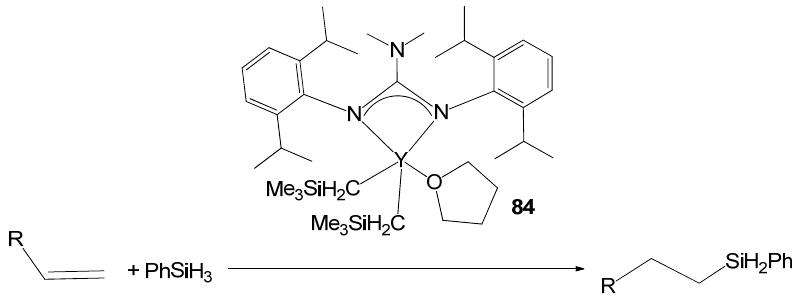
Figure 50. Alkene hydrosilylation with an yttrium guanidinato compound as catalyst.